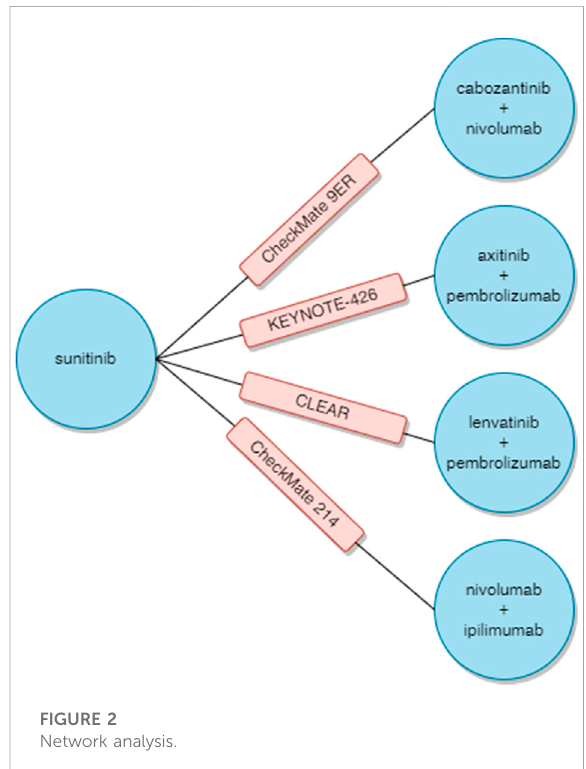
FIGURE 2 Network